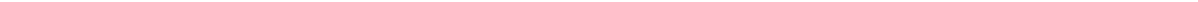
Fig. 2 RhoGEF2 optogenetic activation triggers apical constriction. a – d Confocal still frames from a time-lapse recording of a representative embryo ( N = 3) co-expressing CIBN::pmGFP, RhoGEF2-CRY2::mCherry, and the plasma membrane marker Gap43::mCherry. a The dorsal epithelium prior to two-photon illumination as visualized by imaging Gap43::mCherry, note that with the imaging setting used, the cytoplasmic signal of RhoGEF2-CRY2::mCherry was not visible. Blue rectangle indicates area of photo-activation. Cells within the magenta rectangle were de fi ned as boundary cells. Cells contained within the gray and magenta rectangle corresponded to non-activated cells. b and c show fi nal still frames after 8 min of continuous two-photon illumination. b shows the apical-most plane. c shows a focal plane 10 µ m basally to the focal plane in b . Individual cells marked with a dot (color-coded as indicated above) were tracked over-time and their apical area was quanti fi ed, as presented in f . Scale bars, 10 µ m. d , e Detailed analysis of individual cells from the embryo shown in a . d Cell outlines of activated (top row), non-activated (middle row), and boundary (bottom row) cells after photo-activation; dashed line corresponds to the top left corner of the area of photo-activation. Scale bars are 5 µ m. e Quanti fi cation of apical area (left) and eccentricity (right) over time for the individual cells shown in d . f Quanti fi cation of mean apical area over time upon two-photon illumination of activated ( n = 84), non-activated ( n = 82), and boundary cells ( n = 28). Shaded areas indicate s.d. g Mean apical area eccentricity quanti fi ed for the same groups of cells as in f . Shaded areas indicate s.d. h Quanti fi cation of mean apical constriction rate over time for the photo-activated cells in f ( n = 84). Shaded areas indicate s.d. i Quanti fi cation of the constriction rate of individual cells within the photo-activated region ( n = 34). j – r Confocal still frames from a time-lapse recording of a representative embryo ( N = 3) co-expressing CIBN::pmGFP, RhoGEF2-CRY2, and the myosin II regulatory light chain reporter Sqh::mCherry. Images are presented as integrated intensity projections of 5 µ m. The dorsal epithelium was subjected to continuous two-photon illumination within a rectangular area (dashed line). j – l CIBN::pmGFP, ( m – o ) Sqh::mCh, and ( p – r ) composite of both